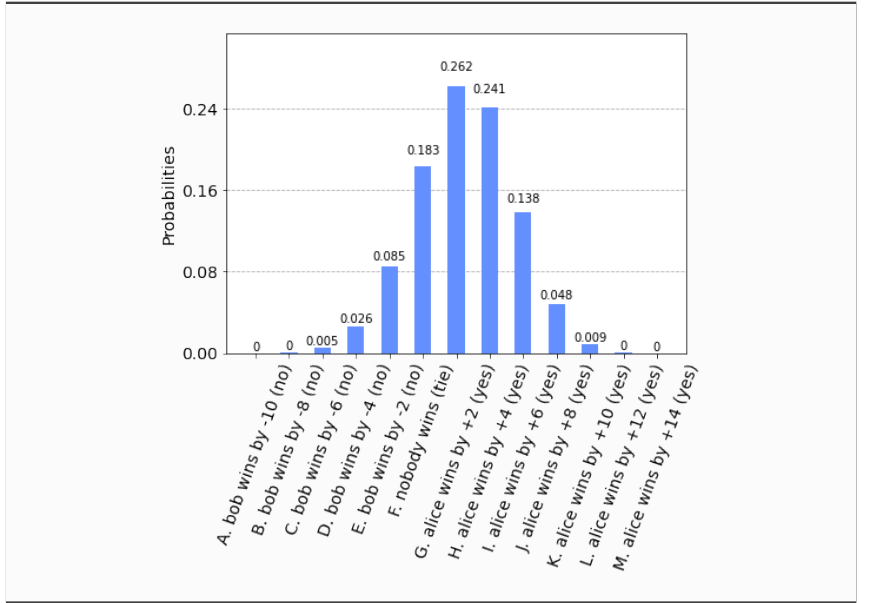
Figure 22. The possible outcomes and their probabilities with 2 independent legislators and r A = r B =